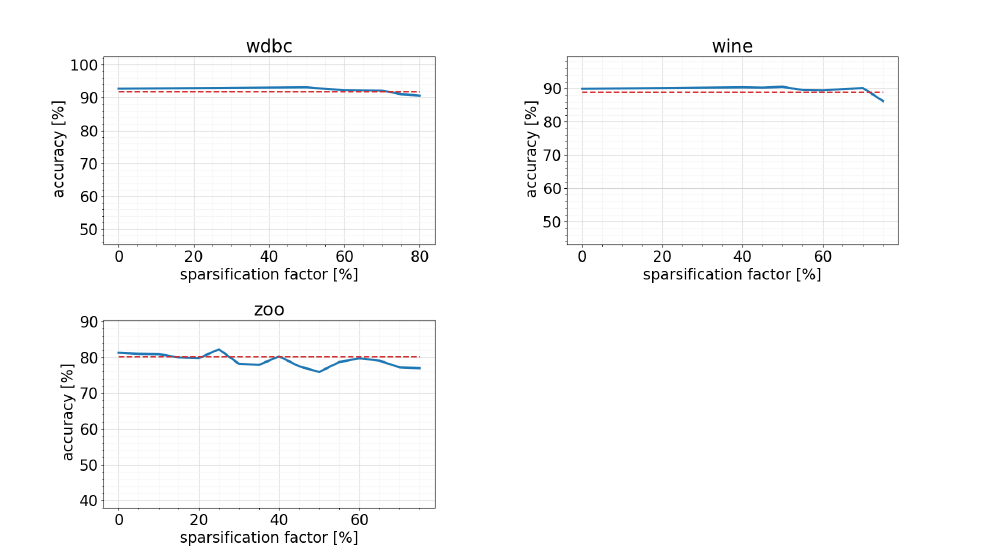
Figure 18. Results of pruning DT structure on wdbc, wine and zoo datasets.